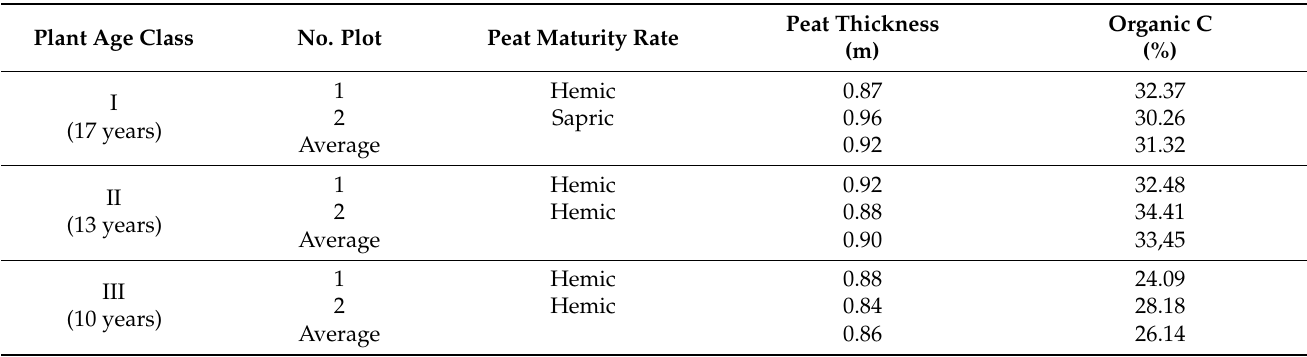
Table 5. Condition and organic C content in peat soil under stands of D. polyphylla for three age classes.